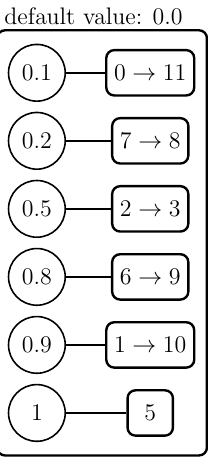
Figure 8. φ ( X 1 , X 2 , X 3 ) as VDI